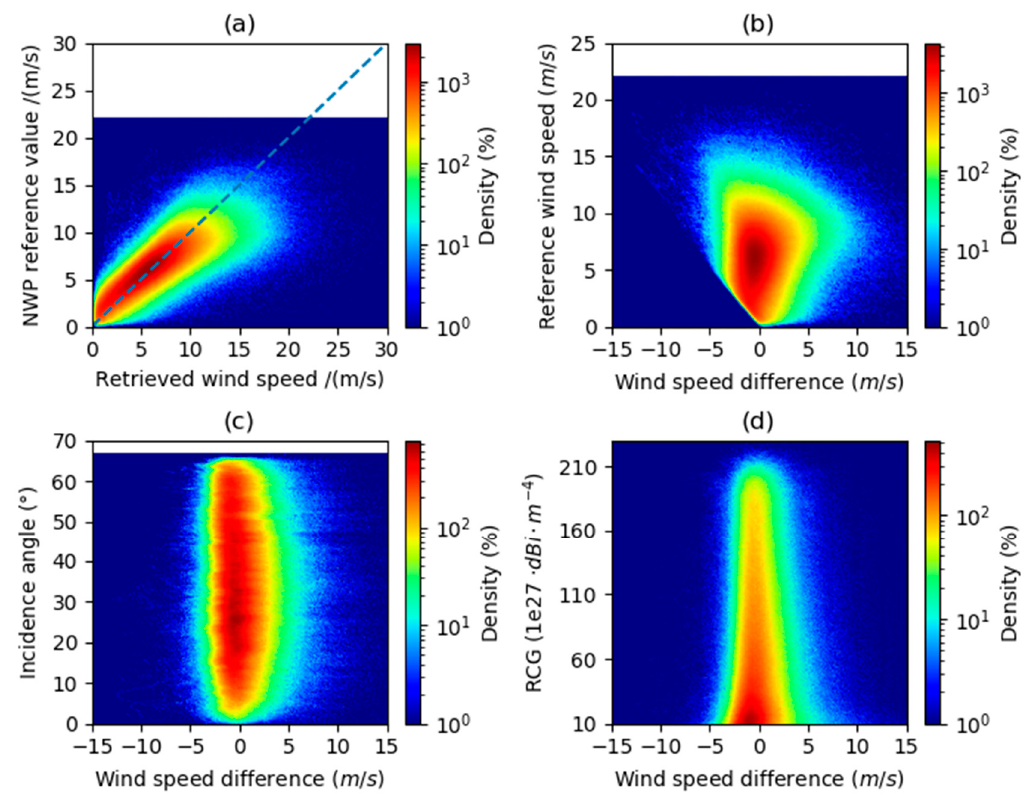
Figure 7. Log(density) scatterplots of the retrieved wind speed with Numerical Weather Prediction ground truth wind speed ( a ), residual versus truth wind speed ( b ), incident angle ( c ), and range-corrected gain ( d ).